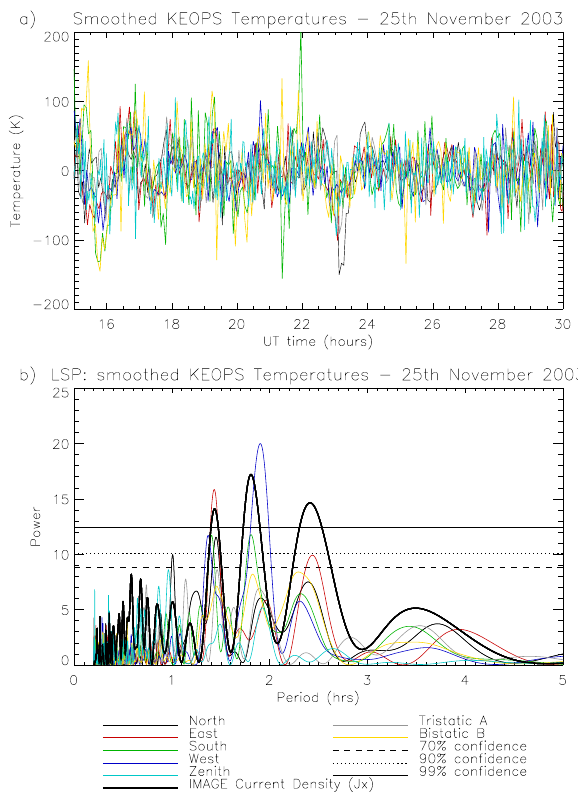
Fig. 8. Neutral temperatures with a 2h smoothed value removed (a) and their periodogram (b) from KEOPS from the 25 Novem- ber 2003. The bottom plot also shows the periodogram for the equivalent current densities (thick black line) from IMAGE data (smoothed and reduced by a factor of 2 for